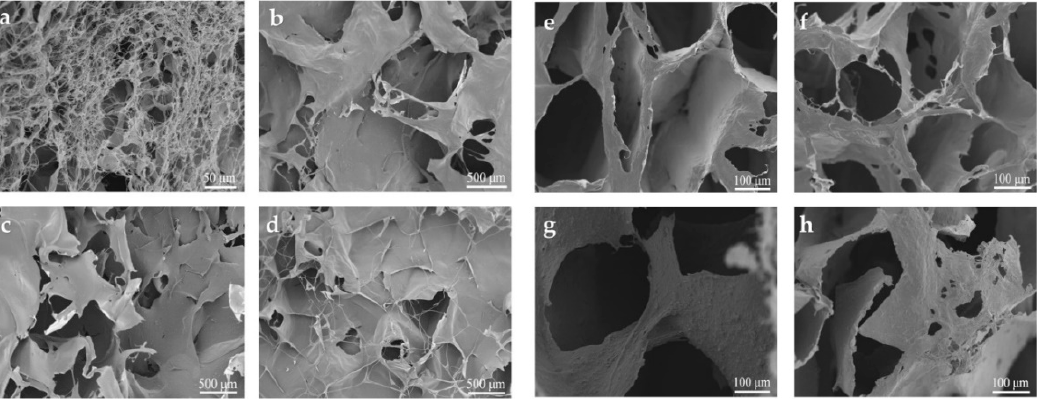
Figure 5. SEM image on upper surface of the aerogel ( a ) pure NFC, ( b ) CCGA 40, ( c ) CCGA 60, ( d ) CCGA 80 and SEM analysis at cross-section of the aerogel ( e ) pure NFC, ( f ) CCGA 40, ( g ) CCGA 60, ( h ) CCGA 80.